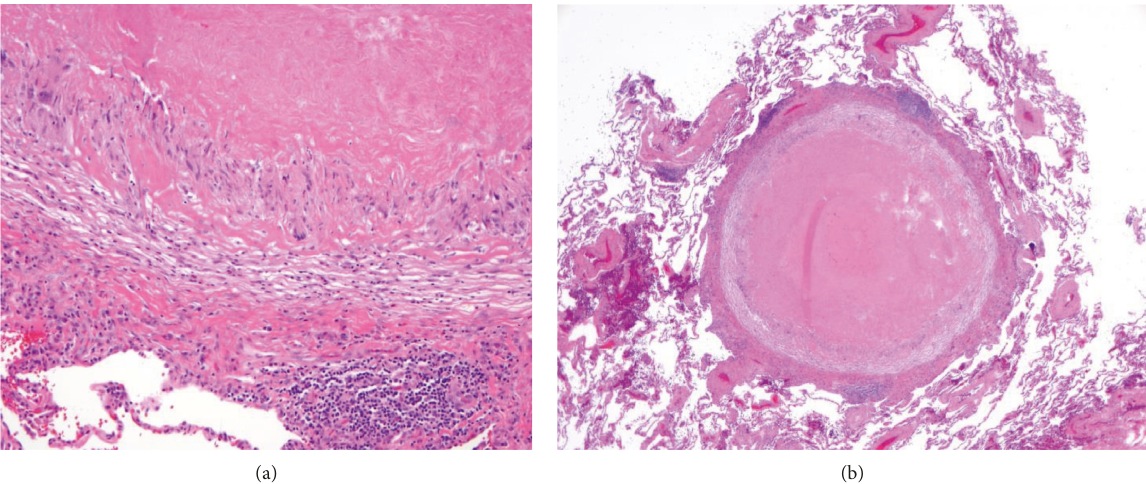
Figure 6: (a) Lung biopsy demonstrating caseating granuloma, magnification 20x. (b). Lung biopsy demonstrating caseating granuloma, magnification